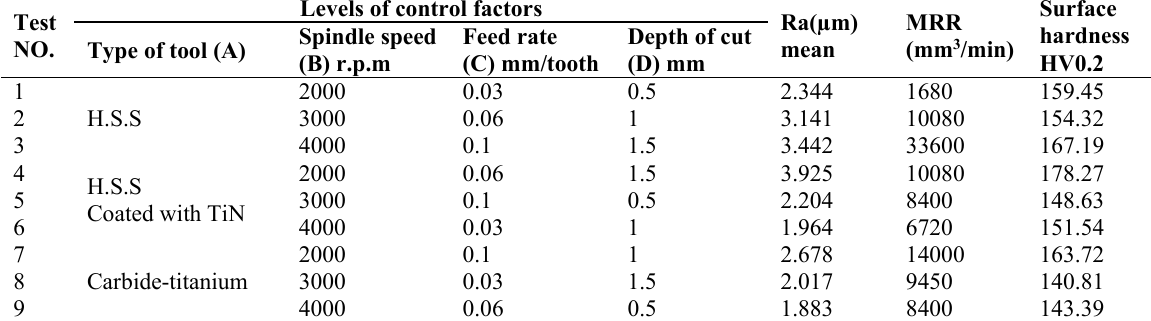
Experimental results of measured outcomes quality